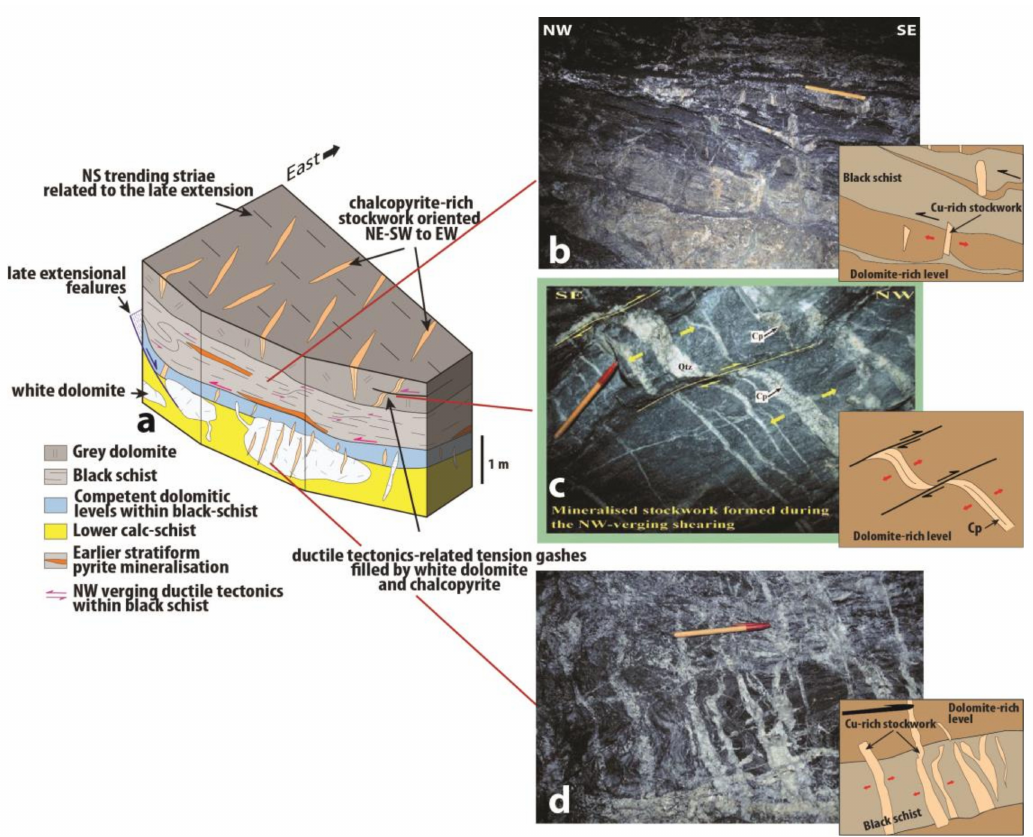
Figure 9. ( a ) Illustrations of the Ifri Cu mine model showing some images of the Cu-rich stockwork formed in response of ductile decollement within black schist. Each photograph is associated to a schematic cartoon in order to explain the geological process. ( b ) Example of vein formation within competent dolomite rich level in response of the ductilely deformed black schist. ( c ) Opening of chalcopyrite/quartz-rich veins due to NW-directed shearing. ( d ) Stockwork formation by contrasted behaviour of dolomite and black